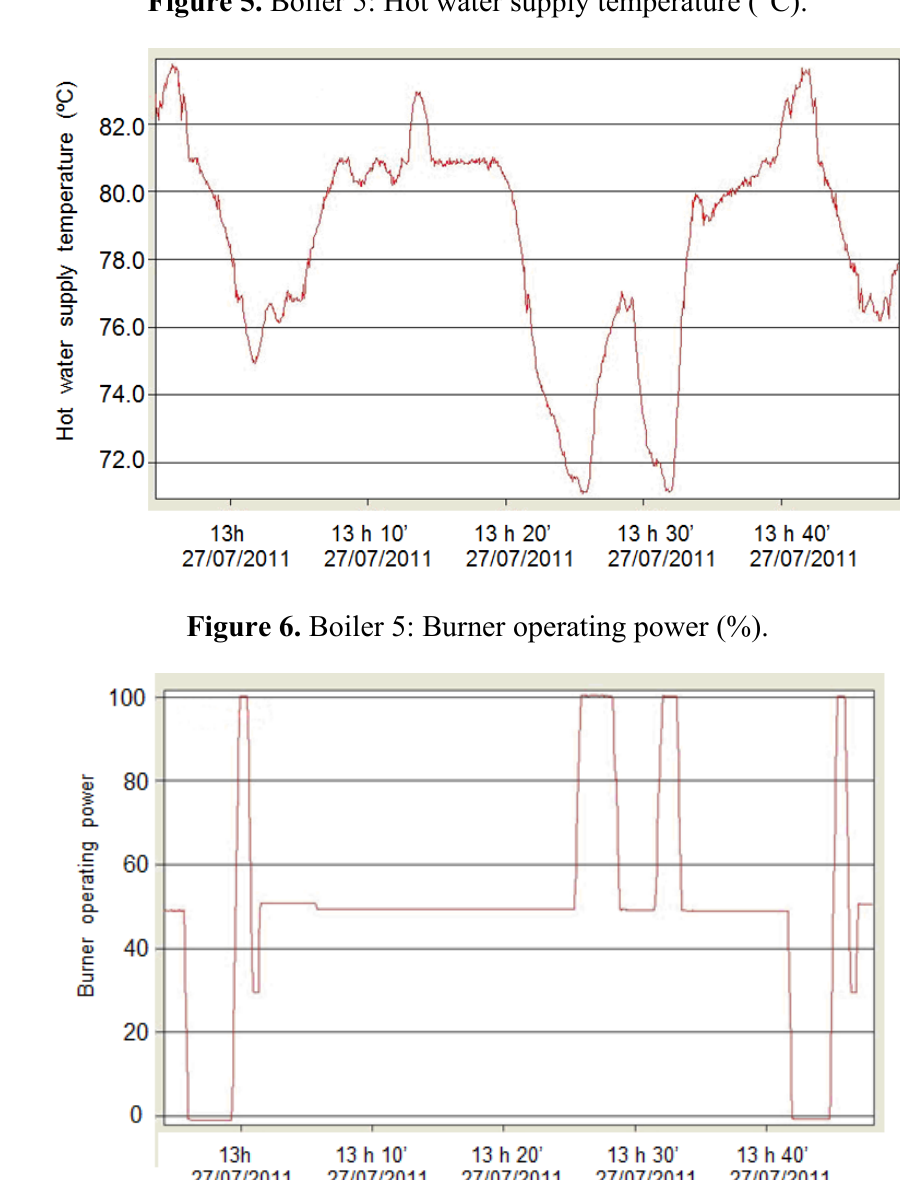
Figure 5. Boiler 5: Hot water supply temperature (°C).